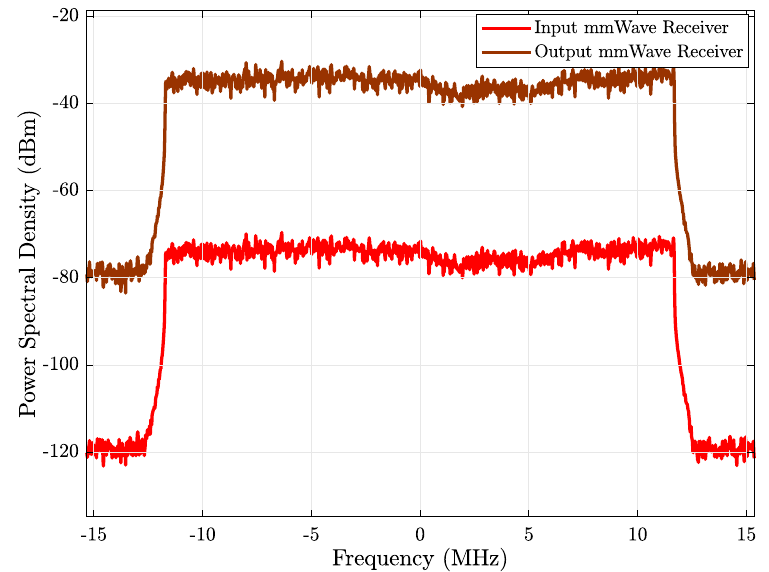
Figure 9. Spectrum of the input and output of the mmWave RF receiver